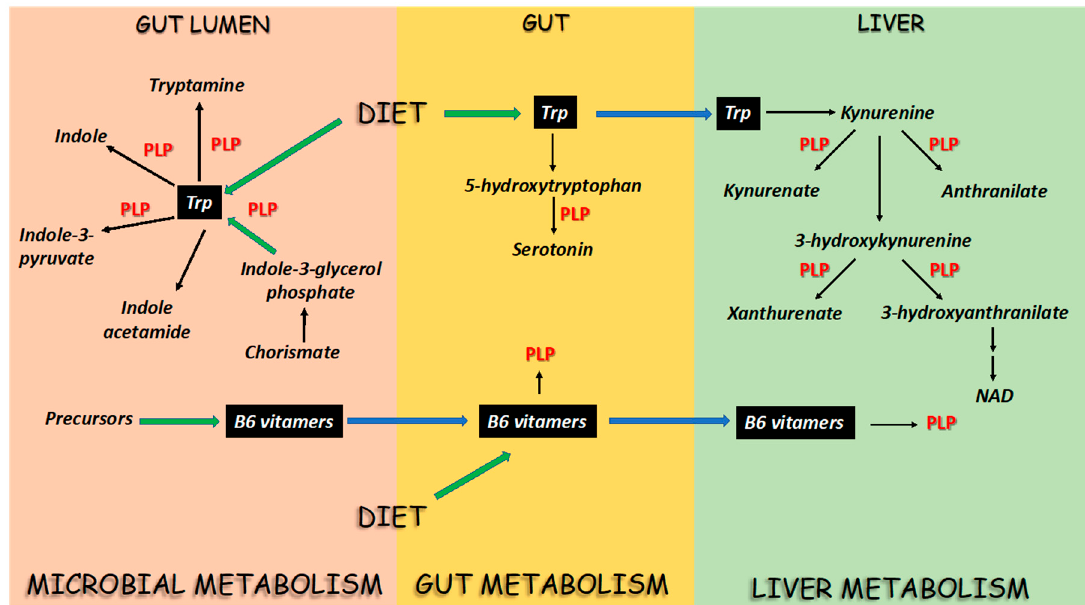
Figure 1. Schematic overview of the microbial and host tryptophan (Trp) and B6 vitamers metabolic pathways. The panel depicts the pathways of Trp and B6 vitamers metabolism in the gut microbiota (pink, left side) and in the host, with particular reference to the gut (yellow, central) and the liver (green, right side) metabolic pathways. The green arrows indicate the source or synthesis of Trp and B6 vitamers, the blue arrows indicate the transport among the different compartments, and the black arrows indicate the metabolic reactions. The panel highlights the distribution of pyridoxal 5 ′ - phosphate (PLP)-dependent enzymes in the microbes and the host governing the synthesis of key Trp metabolites, emphasizing their dependence on B6 vitamer availability. NAD: Nicotinamide adenine dinucleotide. Details are described in the main text.